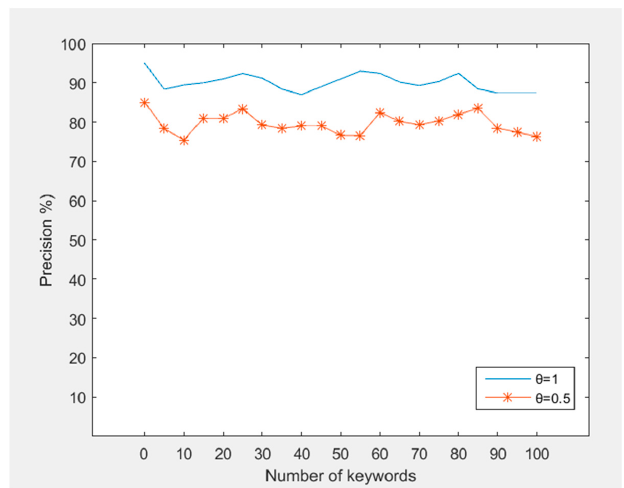
Figure 9. Time of trapdoor Generation.